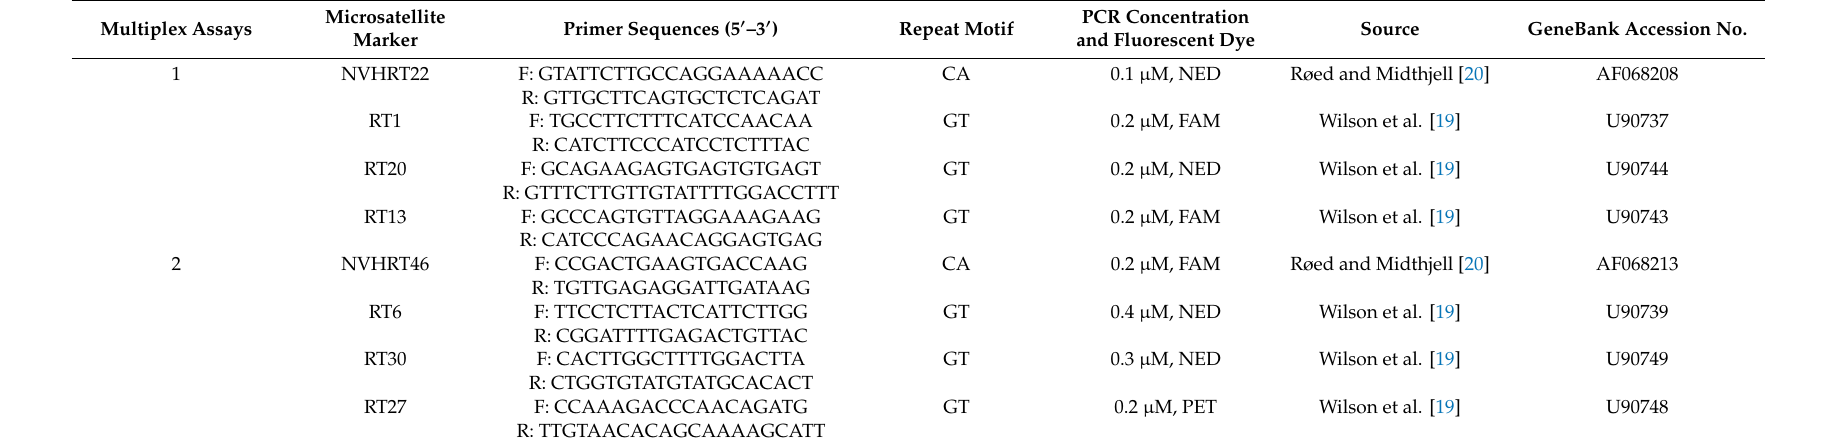
Table 1. Primer characteristics and PCR conditions for the eight microsatellite markers in Rangifer